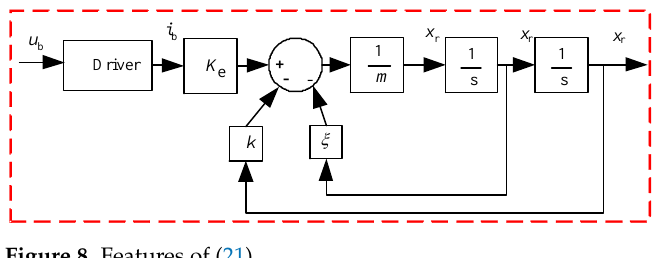
Figure 8. Features of